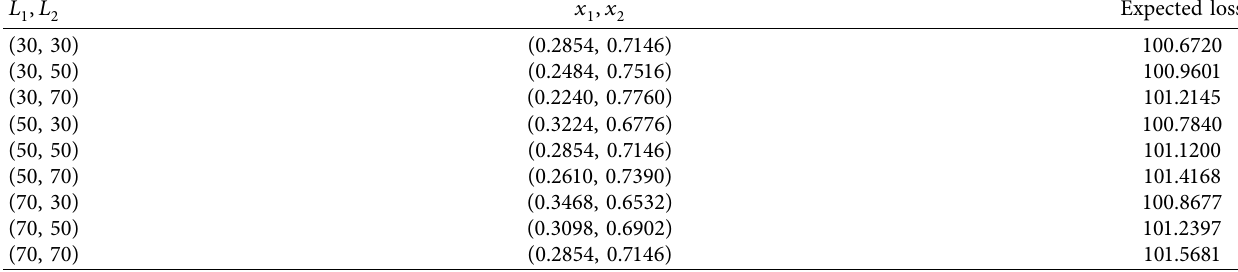
and L on the expected loss. 1 2